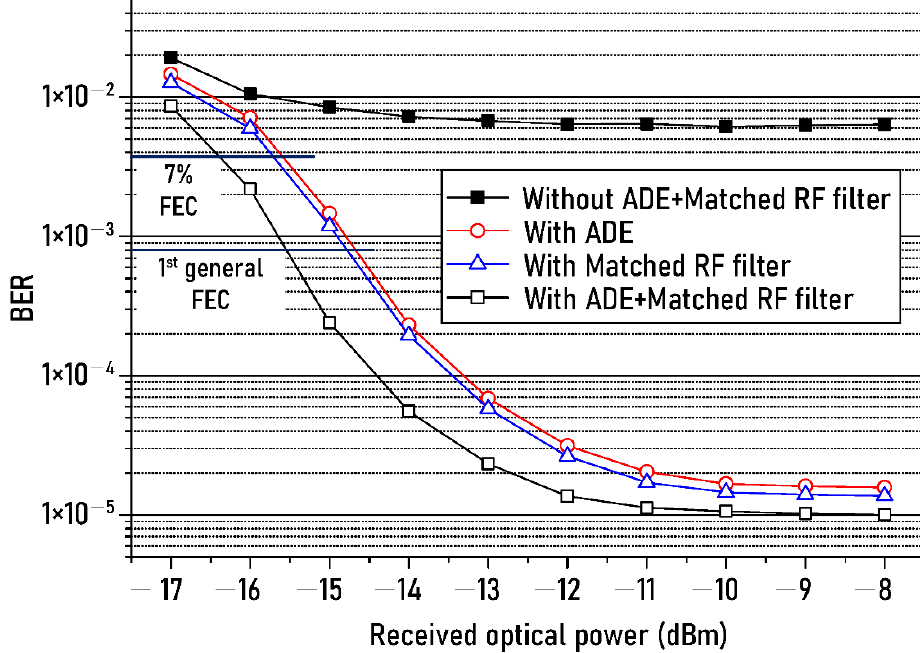
Figure 8. BER changes of recovered NRZ − OOK signal against the received optical power.